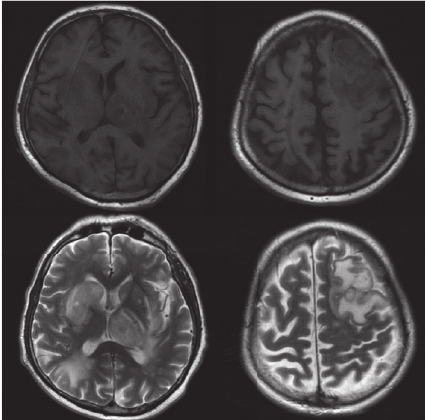
Figure 2: MRI at admission (day 34). Top two images are T2- weighted, middle two are T1-weighted, and bottom two are T2/ FLAIR-weighted. Multifocal enhancing lesions in both cerebral hemispheres and in the left cerebellum concerning metastasis, infection, or inflammatory etiology. Redemonstration of areas of hemorrhage in the left frontal lobe is seen on CT scan. 4mm left to right midline shift is present. Centrally necrotic lesion in the left thalamus measures 14 × 11mm. Lesion in the right caudate head measures 11 × 10mm. Enhancing lesion in the posterior left cerebellum measures 9 × 6